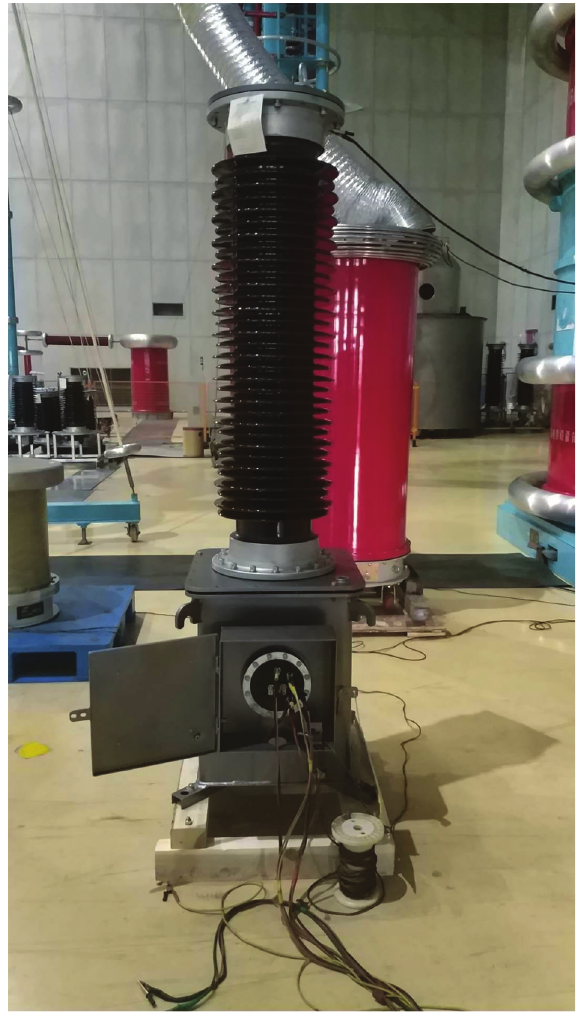
Figure 4: Test platform of the CVT.